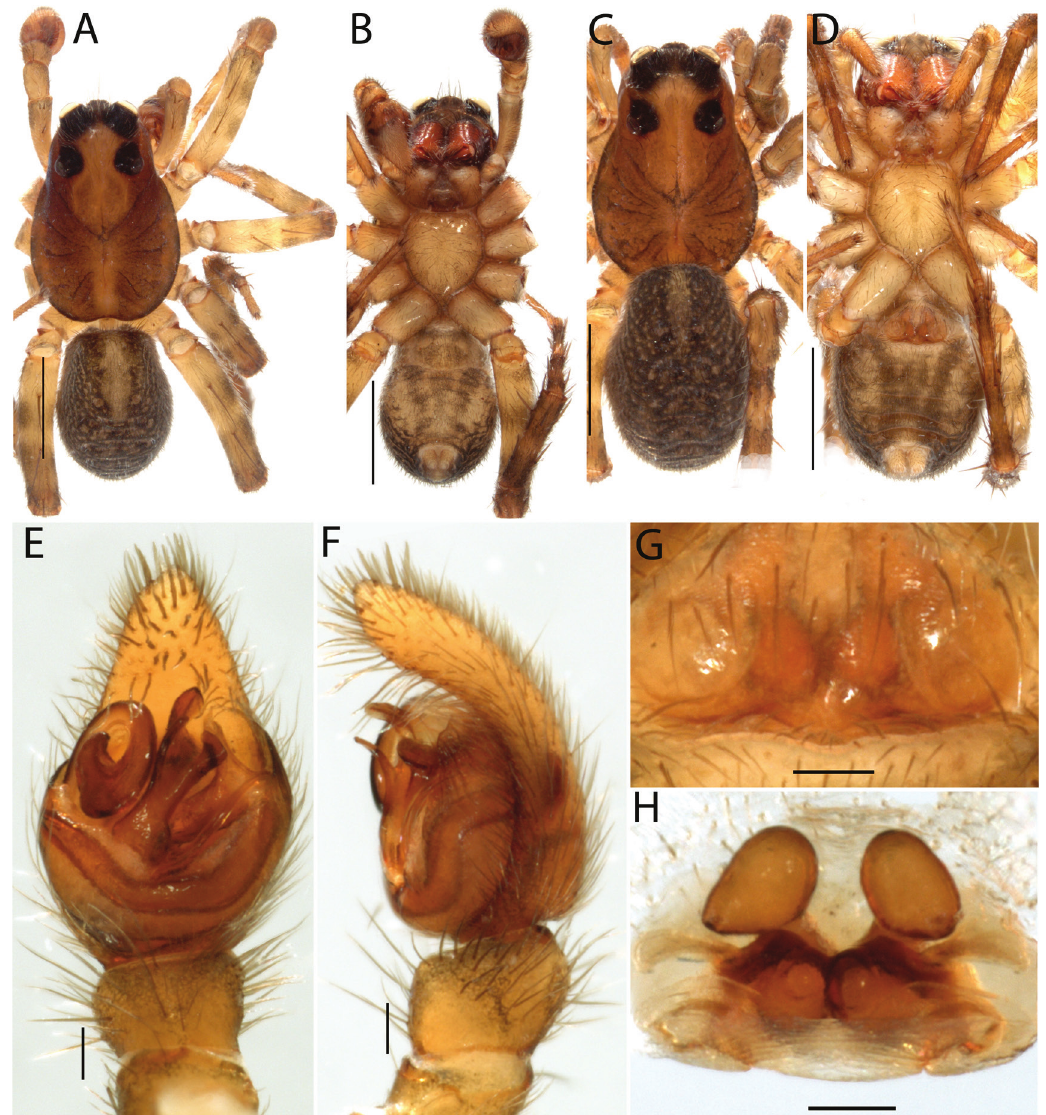
Figure 18. Artoria extraordinaria sp. n. , male holotype (AM KS128074), female paratype (AM KS68638): A , male habitus, dorsal view; B , male habitus, ventral view; C , female habitus, dorsal view; D , female habitus, ventral view; E, male pedipalp, ventral view; F , male pedipalp, retrolateral view; G , epigyne, ventral view; H , epigyne, dorsal view. Scale bars: habitus 1.0 mm; pedipalp, epigyne 0.1